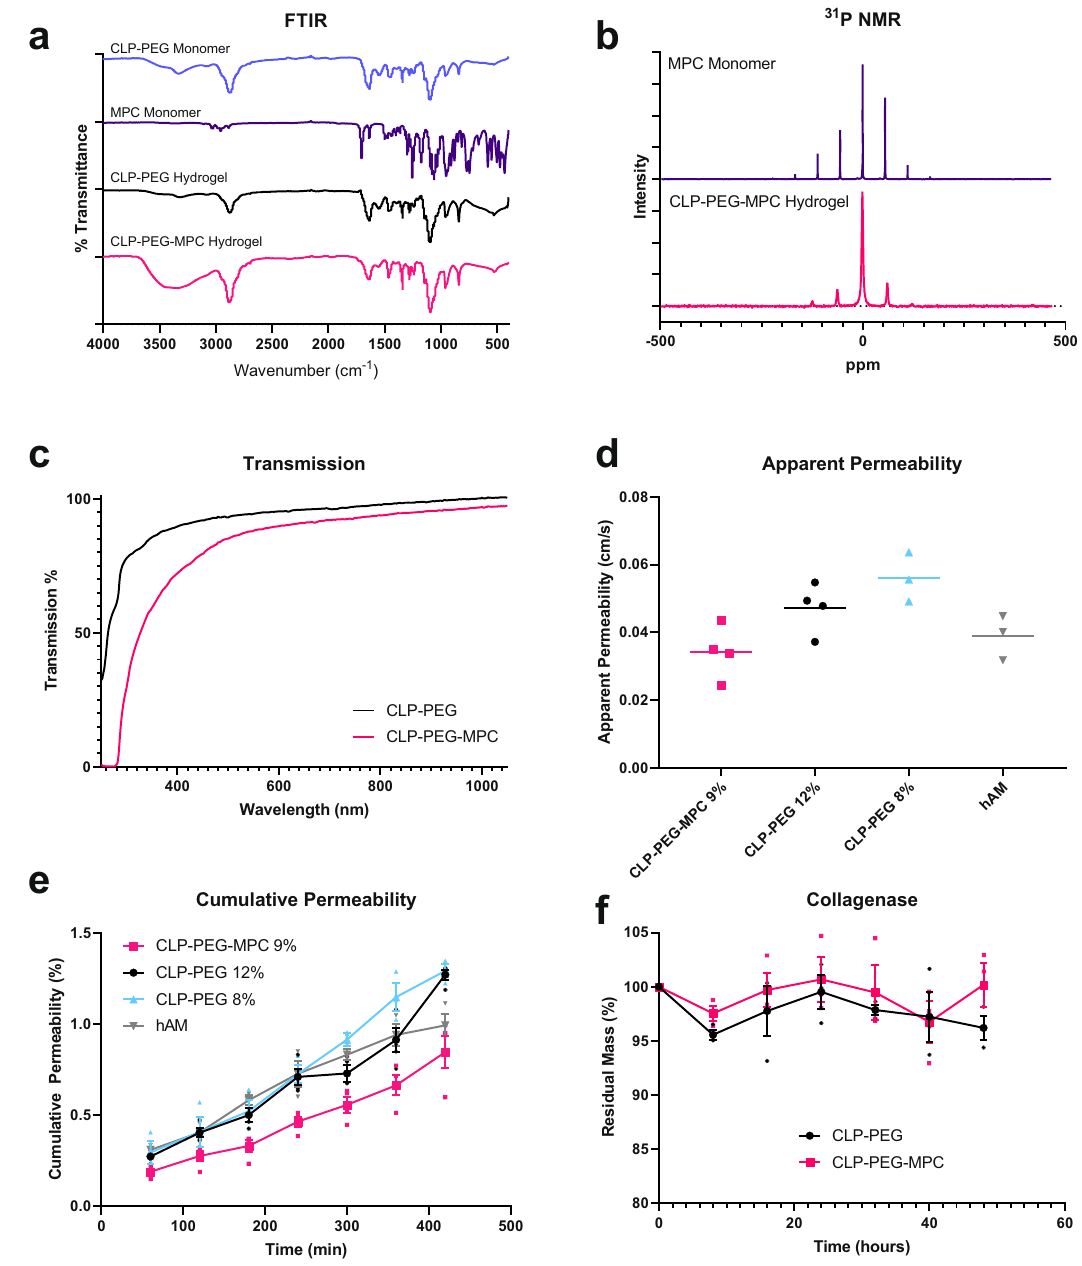
Fig. 1 Chemical and optical analyses of CLP-PEG-MPC and CLP-PEG hydrogels. a Fourier transformed infrared spectroscopy shows the incorporation of the CLP-PEG monomer (lavender line) into the CLP-PEG hydrogel (black line) the CLP-PEG monomer and MPC monomer (purple line) into the CLP-PEG- MPC hydrogel (pink line). b 31 P NMR spectroscopy with peaks that show the incorporation of phosphorylcholine (purple line) into CLP-PEG-MPC hydrogels (pink line) ( n = 1, per group). c Both CLP-PEG (black line) and CLP-PEG-MPC (pink line) hydrogels transmit the full spectrum of visible light, but CLP-PEG-MPC blocks short UV wavelengths ( n = 1, per group). d , e Apparent and cumulative permeability of 700 Da Alexa Fluor ® 568 hydrazide sodium salt through CLP-PEG-MPC hydrogels (pink squares, n = 4 technical replicates (TR)) in comparison to 12 and 8% CLP-PEG (black circles, n = 4; light blue triangles, n = 3 TR, respectively) hydrogels and hAM (gray inverted triangles, n = 3 TR). f Both CLP-PEG-MPC (pink squares) and CLP-PEG hydrogels (black circles) remained stable and minimally degraded when exposed to collagenase enzyme ( n = 3 TR per